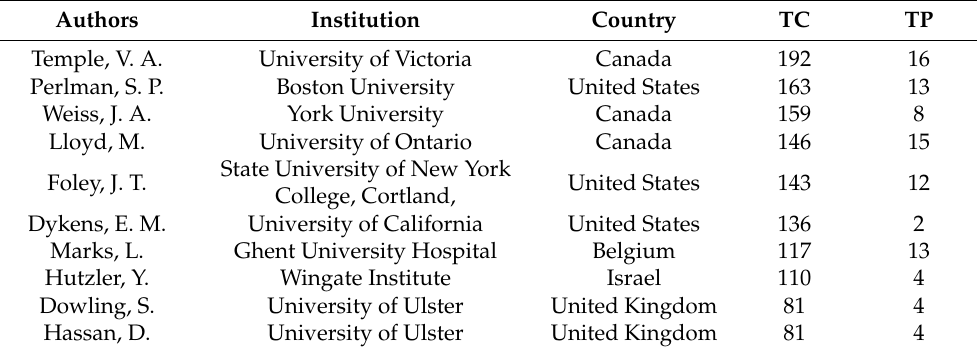
Table 2. The top 10 most influential authors between 1978 and 4 March 2022.